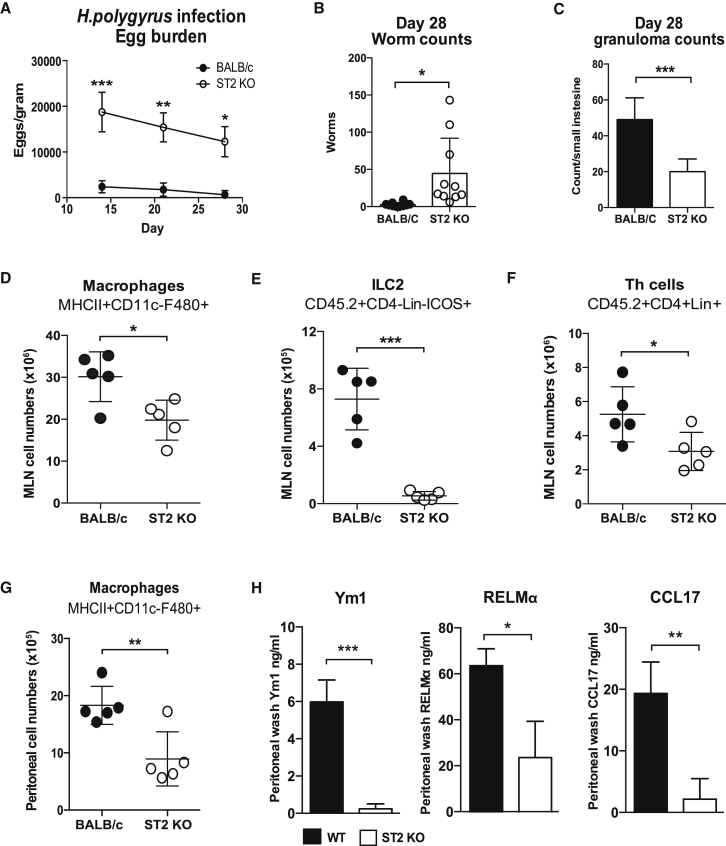
ST2-Deficient Mice Are Fully Susceptible to H. polygyrus Infection(A) Female T1/ST2−/− and wild-type BALB/c mice were infected with 200 H. polygyrus L3 larvae, and egg counts per gram fecal matter were enumerated on days 14, 21, and 28 post-infection.(B and C) Intestinal adult (B) worm burden and (C) granulomas were enumerated on day 28.(D–F) MLNs recovered from H. polygyrus-infected BALB/c and T1/ST2−/− mice were isolated at day 28 post-infection, and absolute numbers of (D) macrophages (F4/80+CD11c−MHCII+), (E) ILC2s (Lineage−CD4−ICOS+), and (F) T helper cells (CD4+Lineage+) were determined by flow cytometry.(G and H) Absolute numbers of (G) macrophages isolated from the peritoneal lavage (gated as in D) were quantified by flow cytometry, and levels of myeloid-derived cytokines (H) Ym1, RELMα, and CCL17 were assessed by ELISA. (A and B) Data are pooled from two independent experiments (n = 10); (C–H) data are representative from one of two experiments and presented as mean values ± SD (n = 5 mice per group; Student’s t test, ∗p < 0.05, ∗∗p < 0.01, and ∗∗∗p < 0.001; NS, not significant).